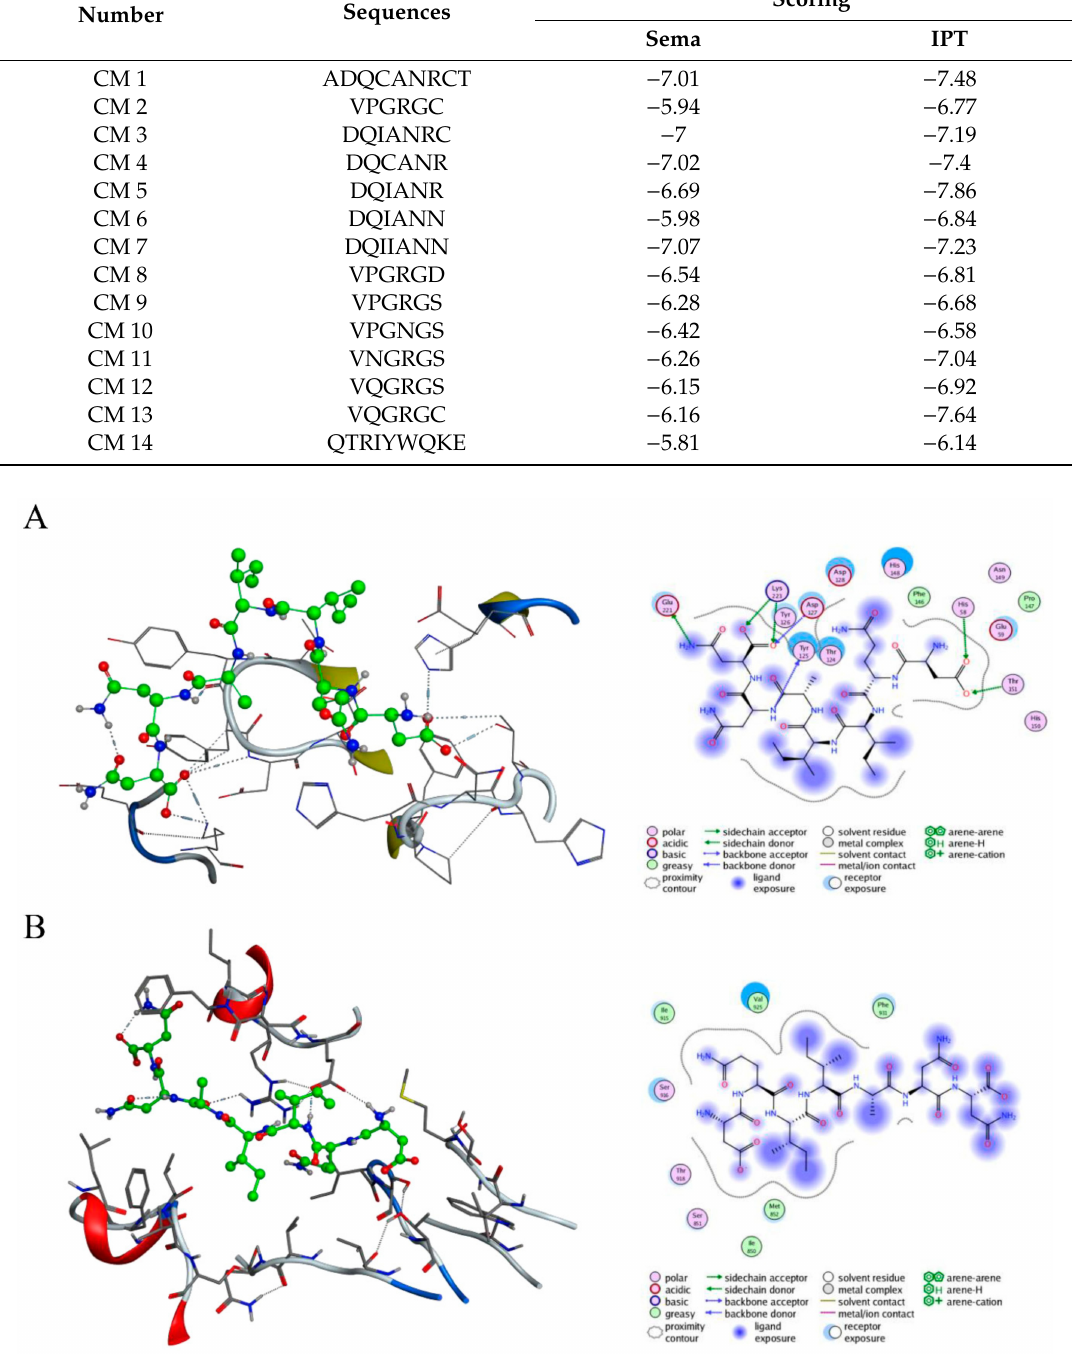
Figure 1. Combination diagram of CM 7 and c-Met. CM 7 is shown in green and c-Met is in gray. ( A ) The interaction between CM 7 and the Sema domain of c-Met (left), and the action site map of CM 7 and the Sema domain of c-Met (right). ( B ) The interaction between CM 7 and the IPT domain of c-Met (left), and the action site map of CM 7 and the IPT domain of c-Met